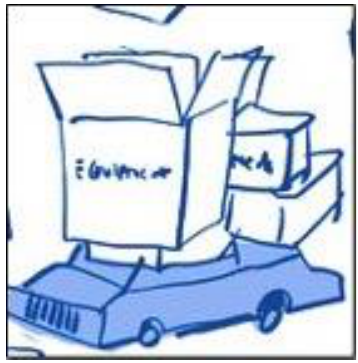
Figure 7. Example of an illustration created from a parent’s account.